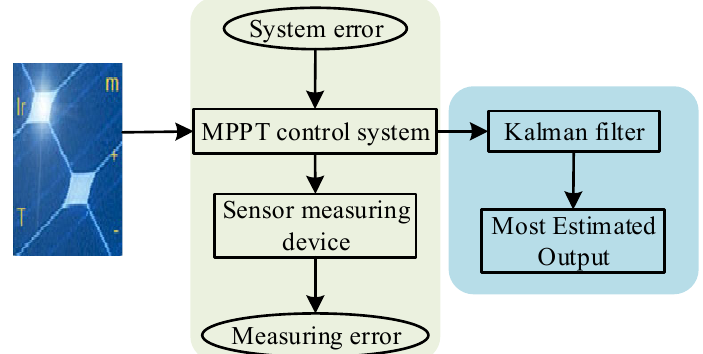
Figure 11. Kalman filter algorithm application diagram.